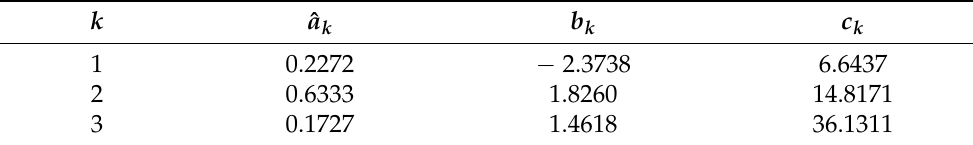
Table 1. Parameters of the normalized GMM ˆ f ( φ ) for latitude φ .